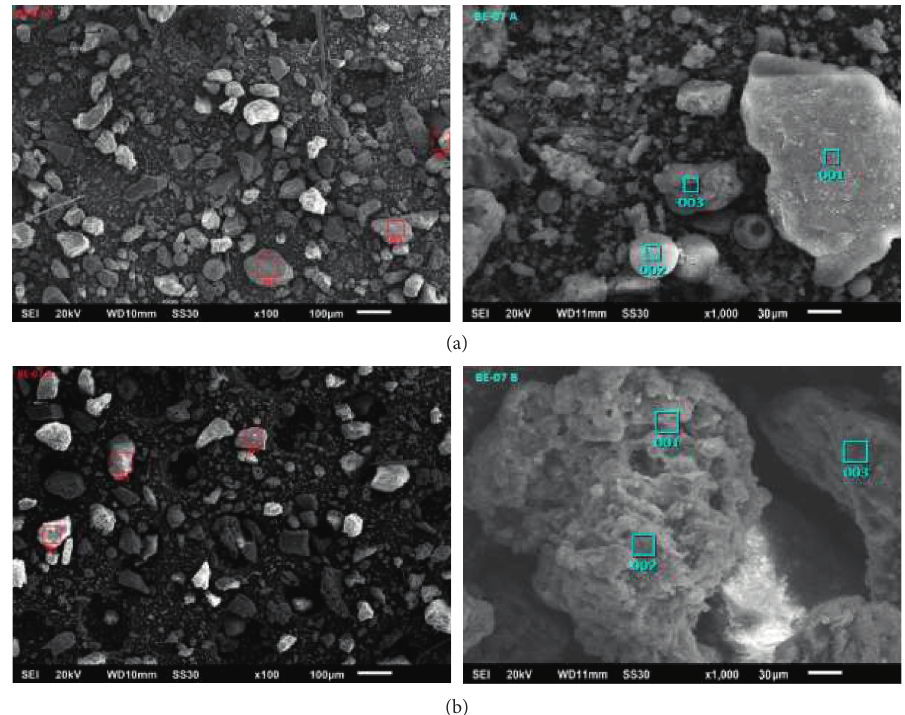
Figure 6: Comparison of 100x and 1,000x magnification of BD-3A at (a) 550 ° C and (b) 600 ° C. Table 10: XRD analysis of BD-3A ash. Temp. ( °